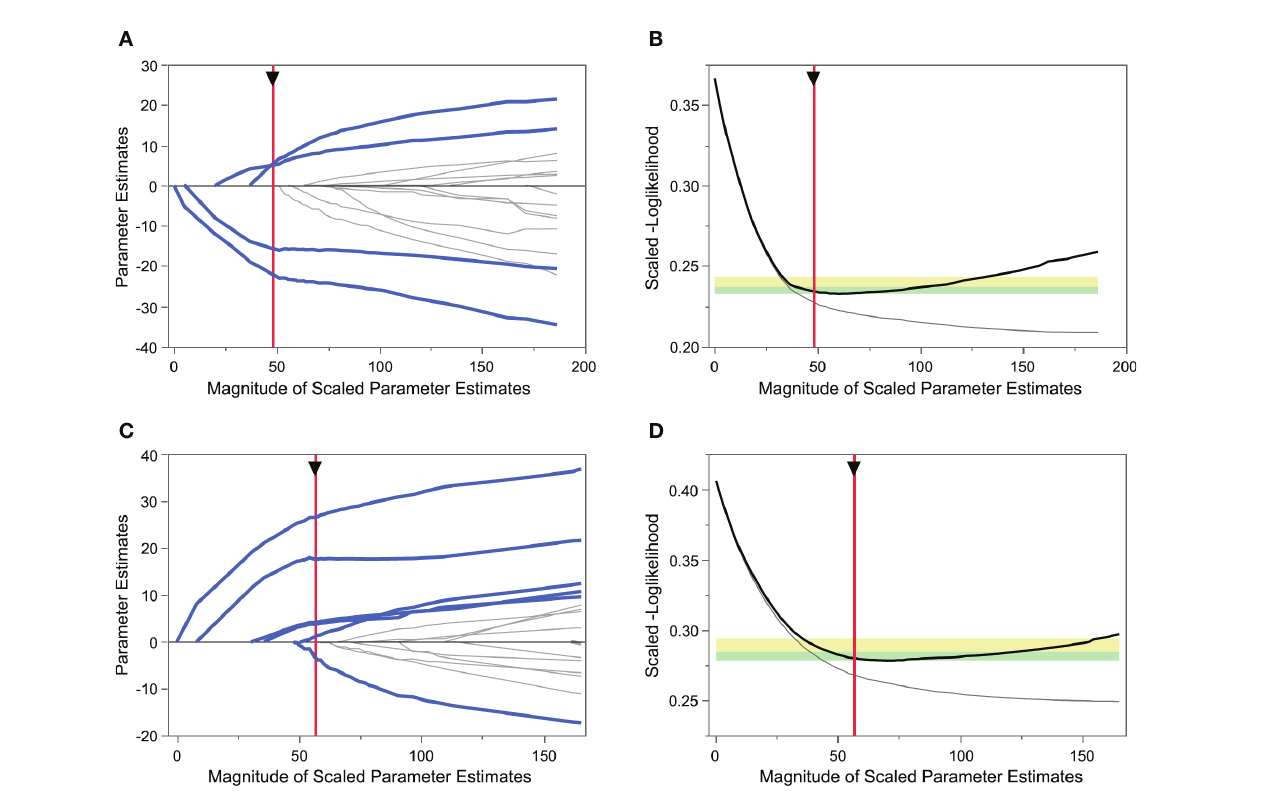
FIGURE 1 Variable selection using the least absolute shrinkage and selection operator (LASSO) logistic regression model. (A) LASSO model showing coef fi cient pro fi les of the candidate variables for predicting poor ovarian response (POR). Each trace represents a regression parameter, and the penalty decreases from left to right. (B) Tuning parameter selection of POR prediction model by 5-fold cross-validation. The vertical red axis indicates the optimal values on the basis of the minimum scaled[-log(likelihood)]. (C) LASSO model coef fi cient pro fi les of the candidate variables for excessive ovarian response prediction. (D) Tuning parameter selection of excessive ovarian response prediction model by 5-fold